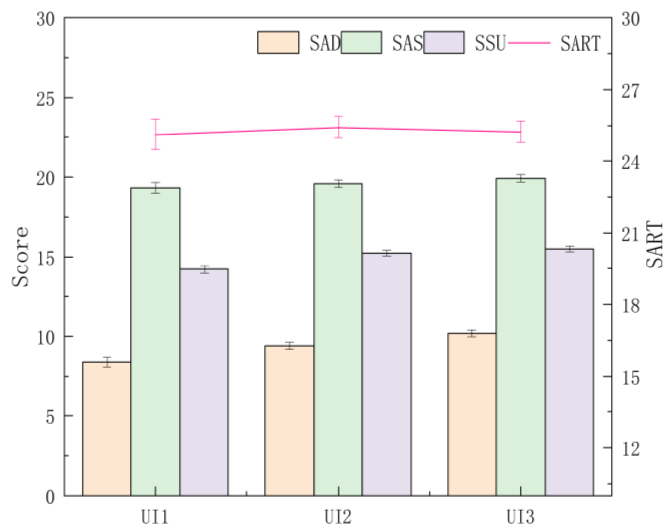
Figure 7. The dimension and total scores obtained by SART for each UI level. Note. Score: the dimension score of SA; SART: total score of SA; AD: attention demand dimension; AS: attention supply dimension; SU: situation understanding dimension; Error bar: standard error.